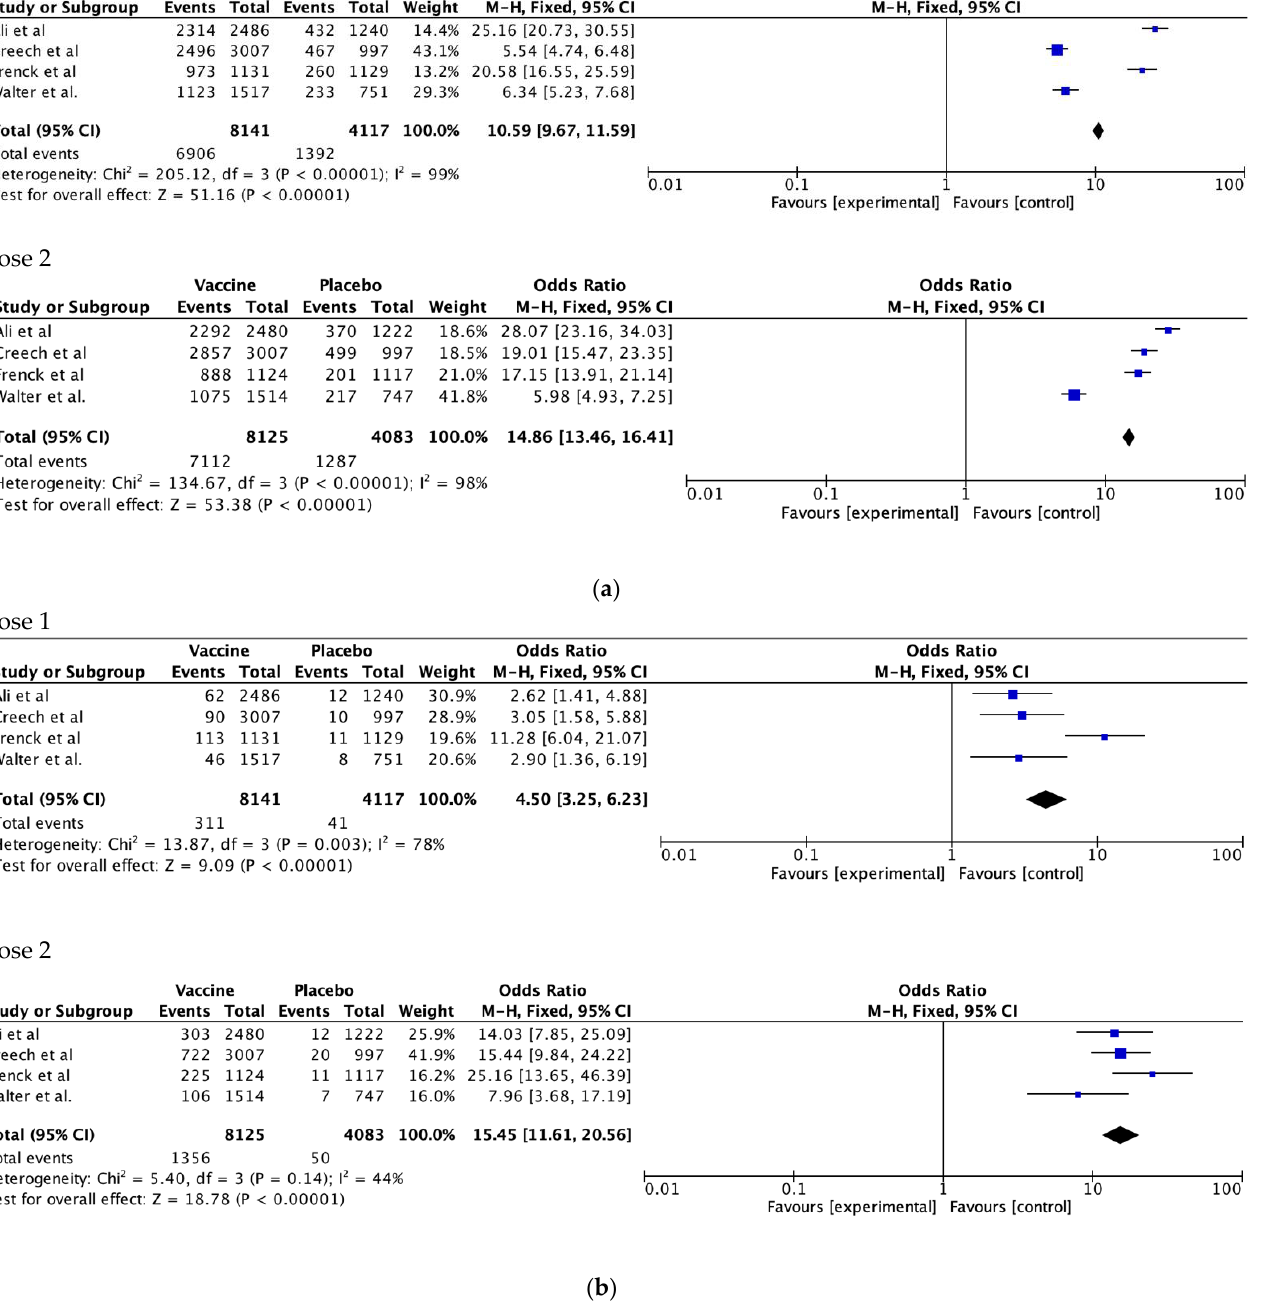
Figure 1. ( a ) Forest plots comparing injection-site pain in participants receiving mRNA vaccines compared with placebos after Dose 1 and Dose 2 [24,26,31,33]. ( b ) Forest plots comparing fever in participants receiving mRNA vaccines compared with placebos after Dose 1 and Dose 2 [24,26,31,33].